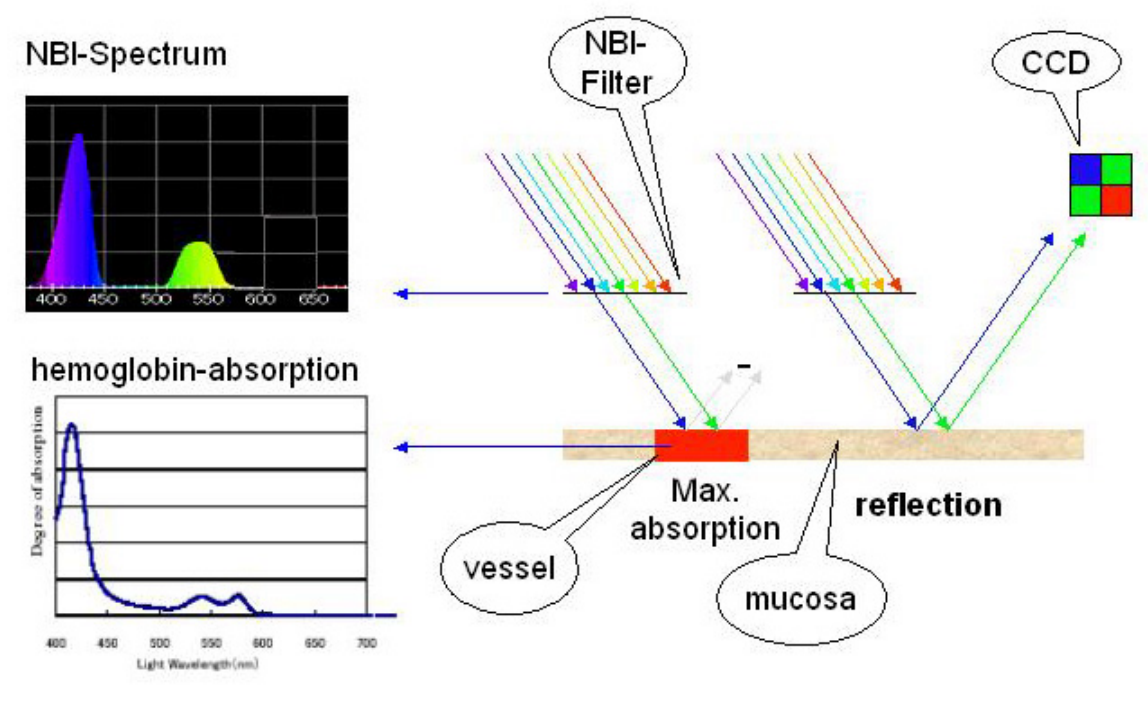
FIGURE 2. Schematic representation of the interactions between tissue and light when using the NBI interference filter: the blue and green bands are absorbed by hemoglobin in the vessels and reflected by the surface of the mucosa. The peak of absorption of hemoglobin is in the blue (courtesy of Olympus Corporation,